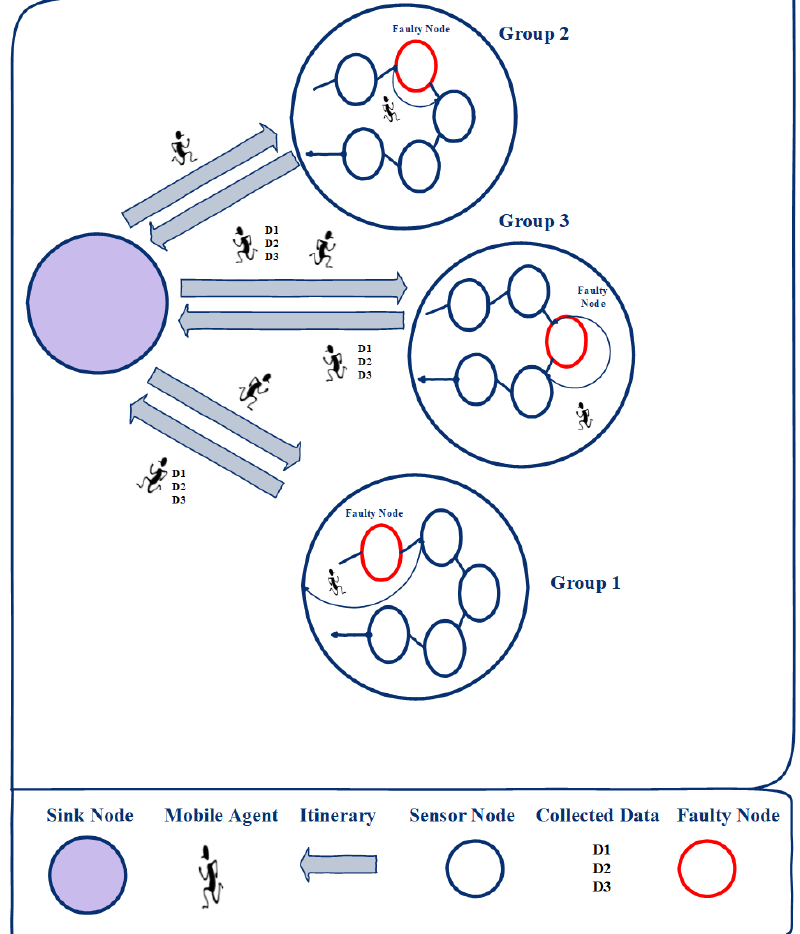
Figure 1. The Proposed Dynamic Approach for Multi-Mobile Agents Itinerary